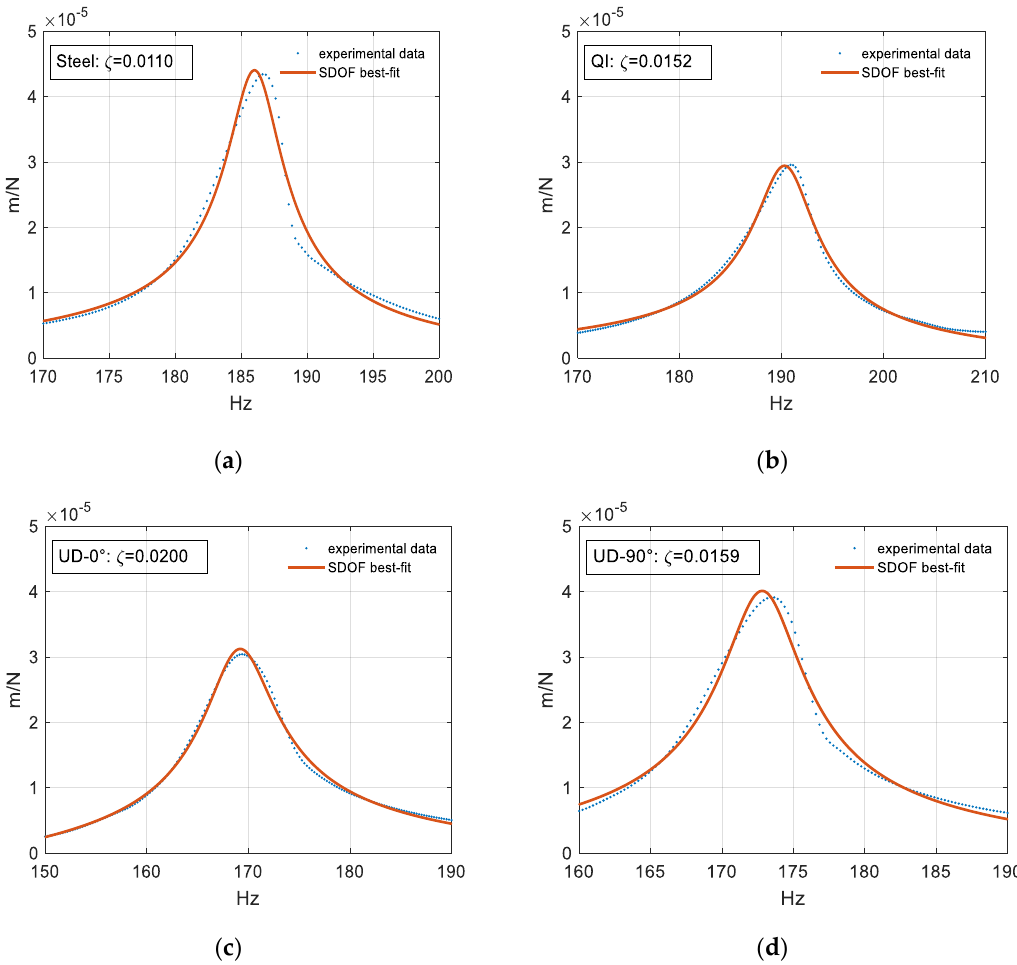
Figure 7. Experimental data and best-fit SDOF model for the set-up with ( a ) the steel specimen, ( b ) the quasi-isotropic (QI) specimen, ( c ) the unidirectional configuration (UD)-90° specimen, and ( d ) the UD-0° specimen.